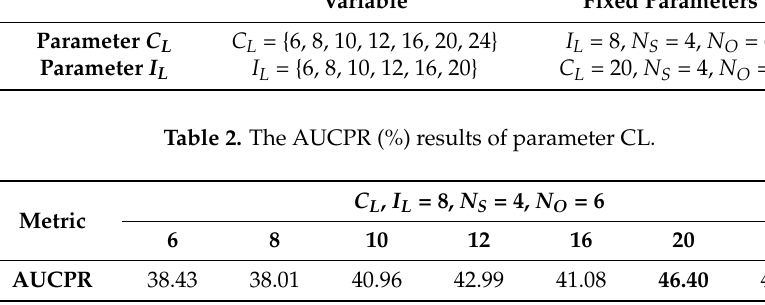
Table 2. The AUCPR (%) results of parameter CL.